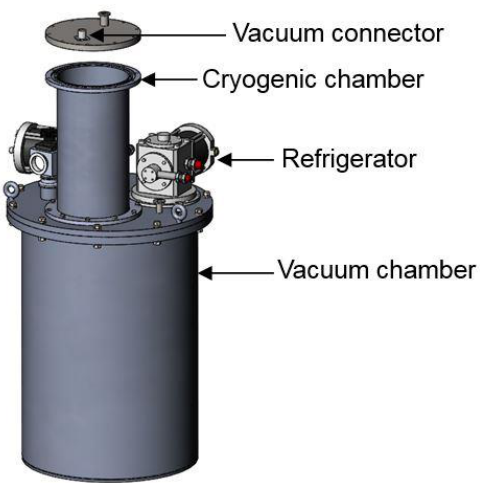
Figure 3. Cryogenic chamber to measure the thermal expansion coefficient of epoxy resin.